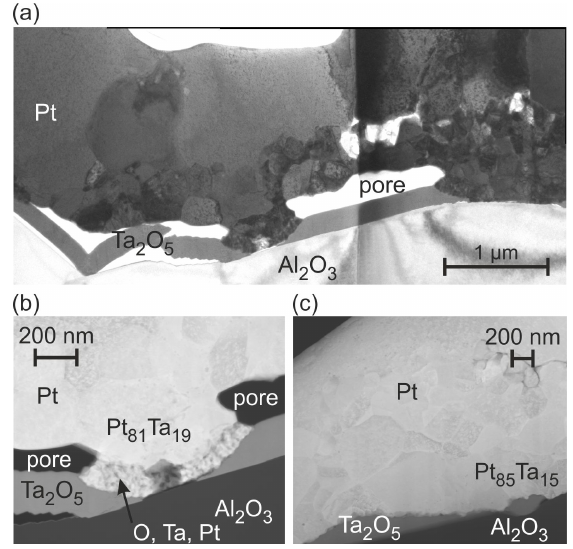
Figure 8. ( a ) TEM image of the Pt ∗ film on Ta seed layer after annealing at 600 ◦ C in air; ( b , c ) HAADF STEM images (chemical contrast) with results of the EDX